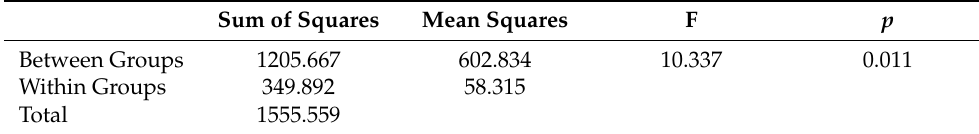
Table 9. ANOVA analysis between the sequences of butt-joint welding. Sum of Squares Mean Squares F p Between Groups 1205.667 Within Groups 349.892 1555.559